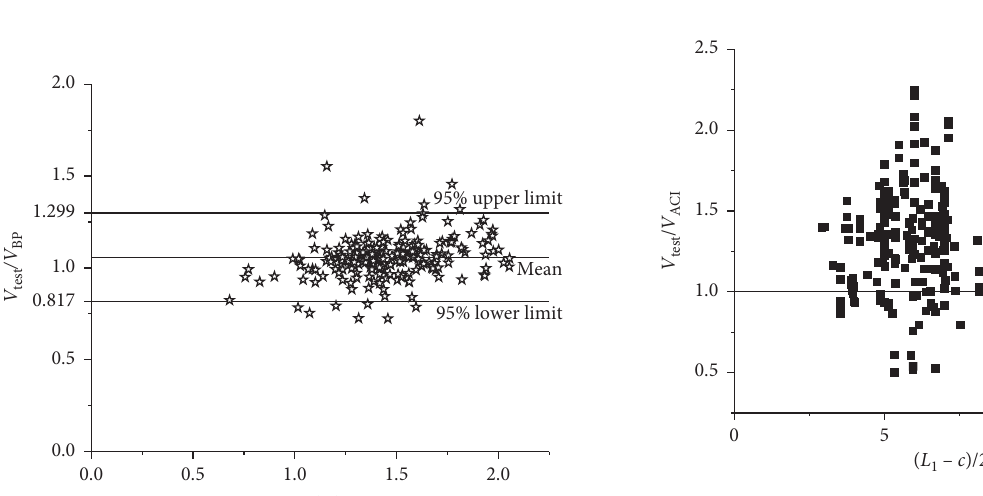
Figure 13: f y influence on ACI 318-14.